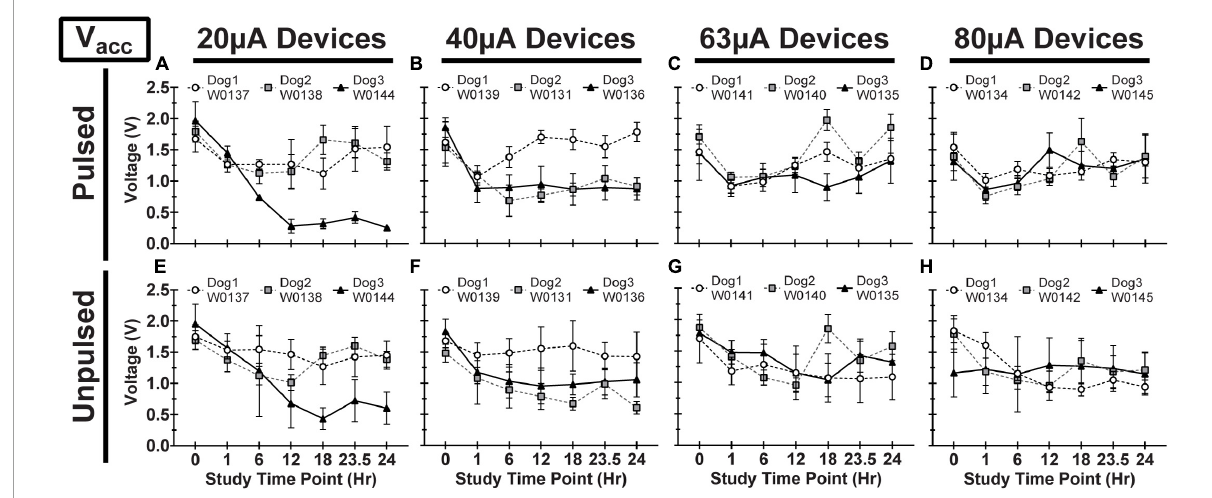
FIGURE8 Access voltage (V acc ) for pulsed (A–D) and unpulsed (E–H) electrodes in WFMA devices in the four different pulsing groups: 20 µ A (A) and (E) , 40 µ A (B) and (F) , 63 µ A (C) and (G) , and 80 µ A (D) and (H) . Voltage transients (VTs) were recorded at 0hr (before beginning the 24-h pulsing study), at 1h, 6h, 12h, 18h, and 23.5h (during the 24-h pulsing study), and at 24 h (after the 24-h pulsing study was complete). All VTs were recorded in response to 40 µ A, 200 µ s pulses. All data shown are mean and standard deviation across all electrodes within the group.